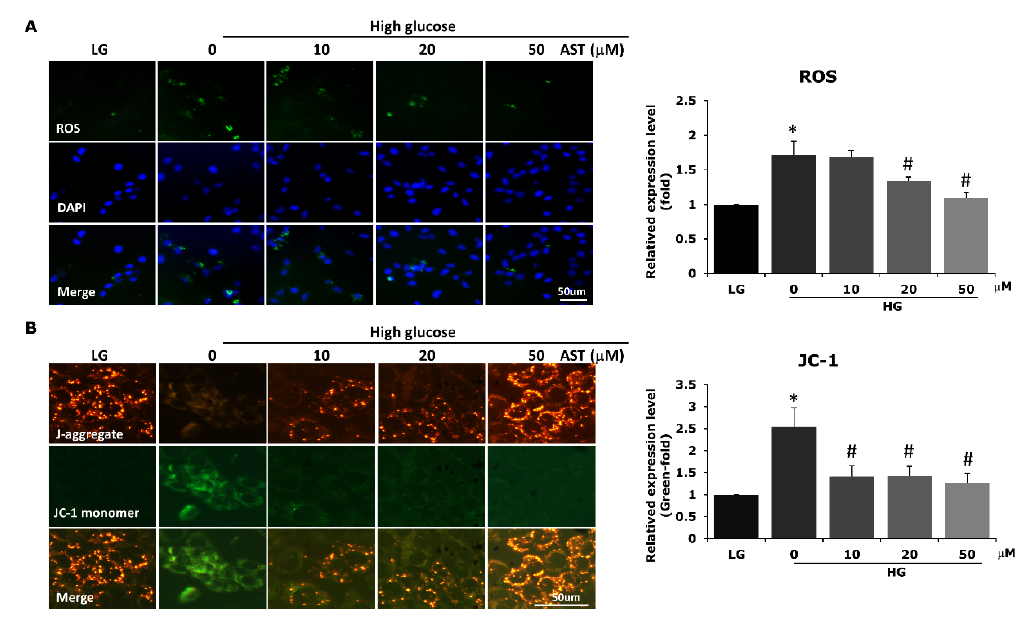
Figure 2. AST reduced ROS and ROS-related mitochondrial damage. ( A ) 661W cells pretreated with different concentrations of AST for 2 h were cultured under high glucose environment. Intracellular ROS levels were detected by measuring the green fluorescence of 2 ′,7′ -dichlorodihydrofluorescein diacetate oxidation. ROS levels were significantly reduced in cells pretreated with 20 and 50 μM of AST. ( B ) Mitochondrial membrane potential was evaluated by JC-1 staining. The results showed decreased mitochondrial damage after AST treatment. AST = astaxanthin; HG = high glucose; LG = low glucose; ROS = reactive oxygen species. * Significantly different from control group ( p < 0.05); # significantly different from high glucose-treated group without AST ( p < 0.05). The Mann–Whitney U test was used to calculate the differences between the means of different experimental groups (three repeats per experiment, three wells per repeat, five images per well analyzed).